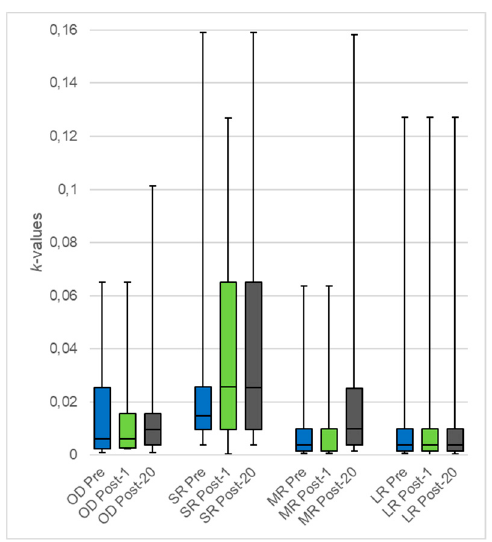
Figure 1. Boxplot for median k -values for the different reward categories pre-post rTMS sessions. OD: overall discounting, SR: small rewards, MR: medium rewards, LR: large rewards, Pre: pre-rTMS sessions / baseline measure (blue), Post-1: post-first rTMS session (green), Post-20: post-20 rTMS sessions